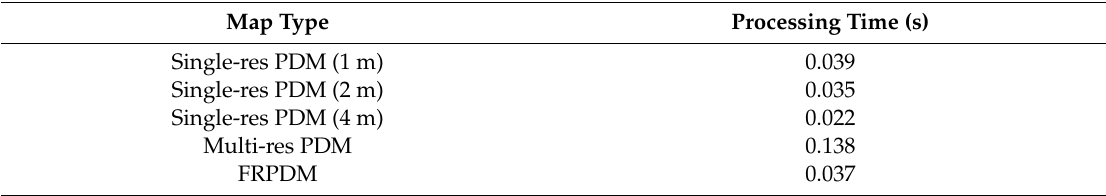
Table 4. Comparison of Map Matching Processing Times.